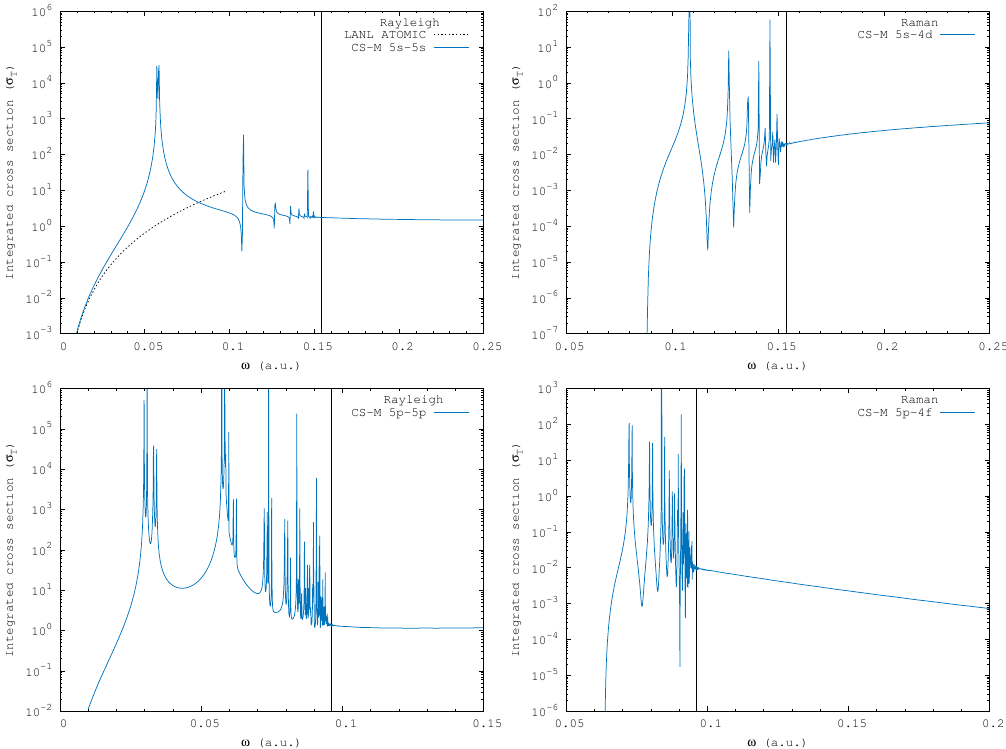
Figure 8. Same as Figure 5 but for rubidium.